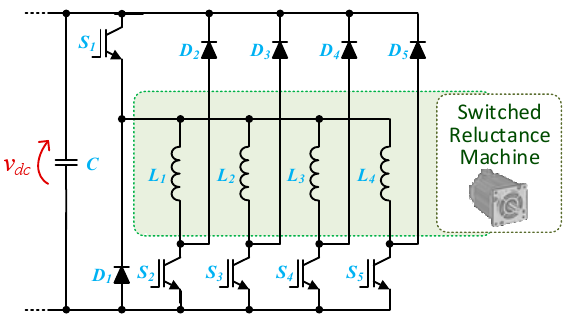
Figure 21. Miller power converter for switched reluctance machines.